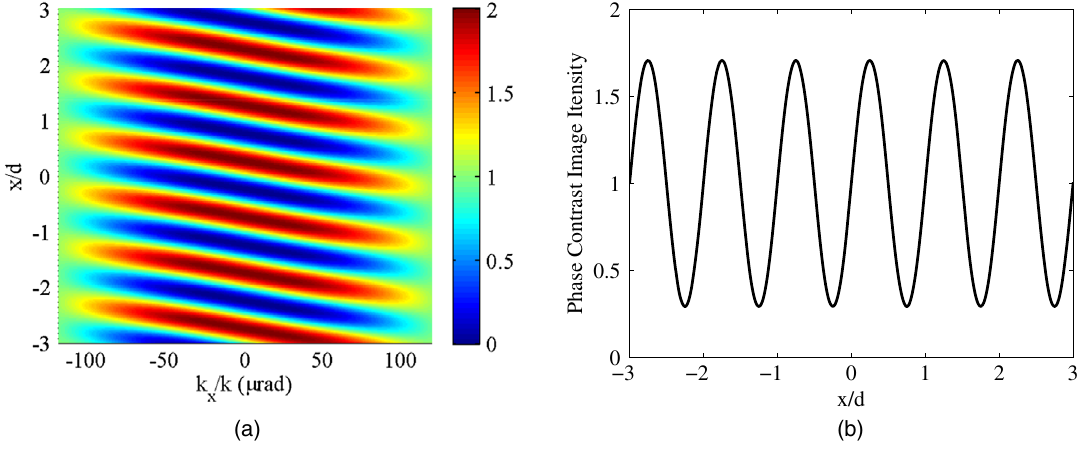
FIG. 10. (a) Phase-contrast modulation as a function of incident angle and transverse position. (b) Integrated phase-contrast ≈ 50 μ rad) at the exit of the Si modulation over the incident electron distribution ( σ x 0